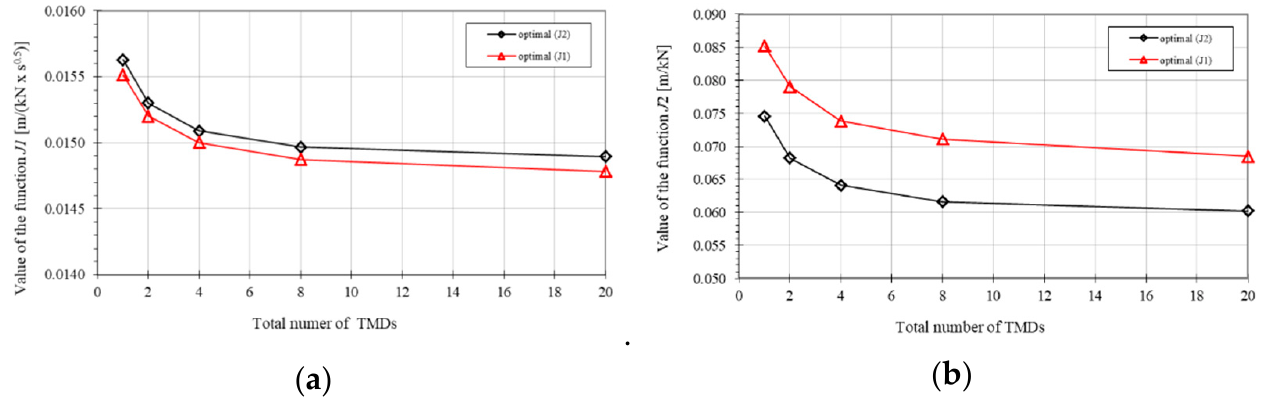
Figure 12. Objective function values based on the optimal parameters obtained from J 1 and J 2, depending on the number of TMDs: ( a ) value of J 1; ( b ) value of J 2.